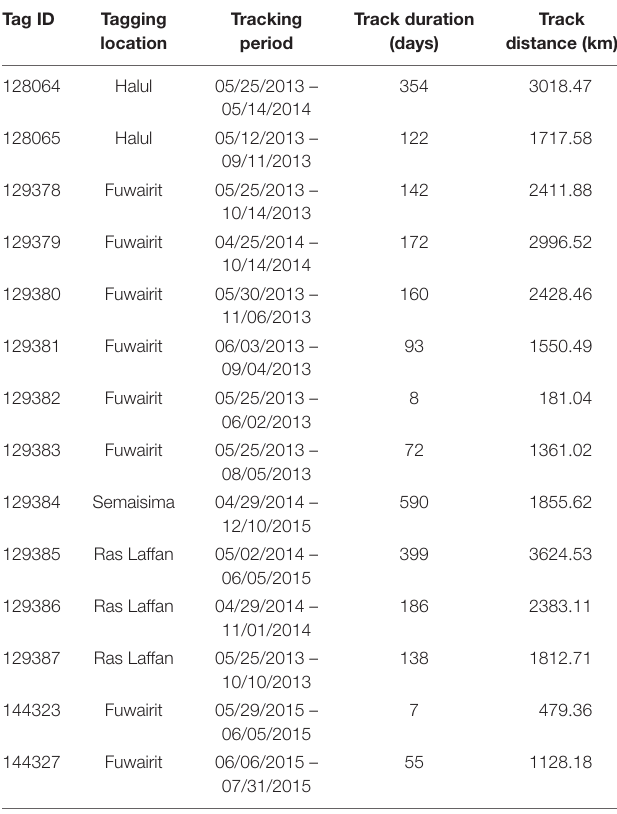
TABLE 1 | Biometric data for the 14 hawksbill turtles that were tagged and